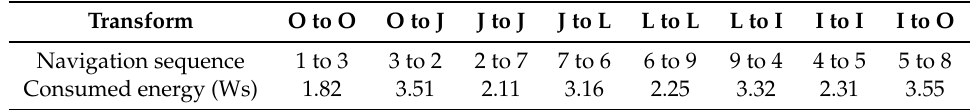
Consumed energy to navigate from source to destination waypoints of proposed trajectory Figure